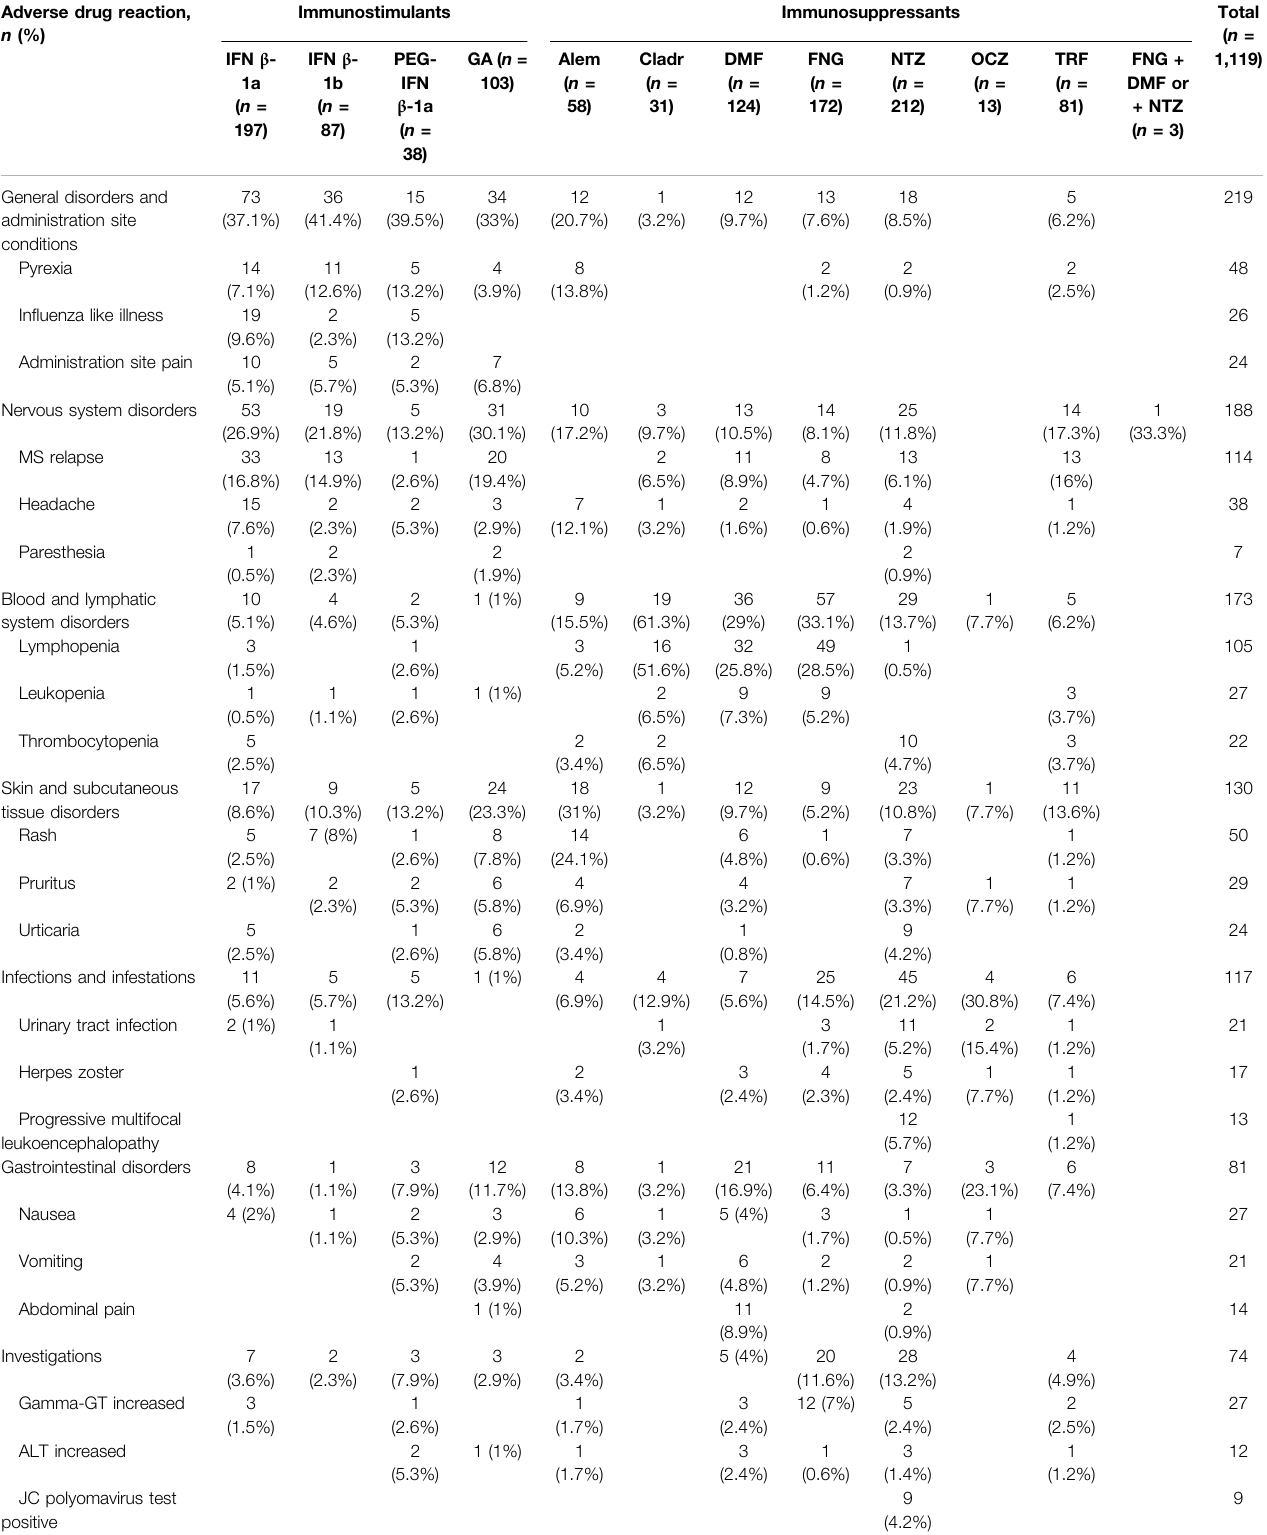
TABLE 4 | Descriptions of main Sicilian ADRs associated with drugs for MS treatment and reported into the RNF. Adverse drug reaction, n